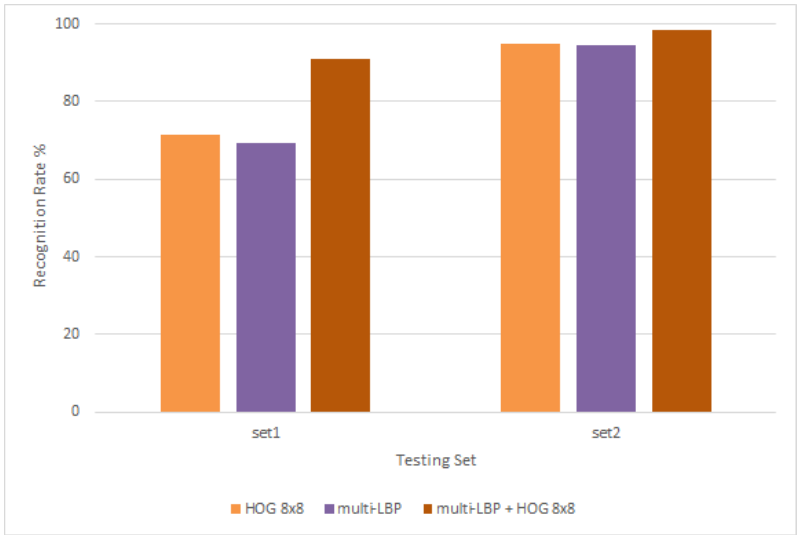
Figure 12. Experiments carried out using HOG with a cell size of 8 × 8 and